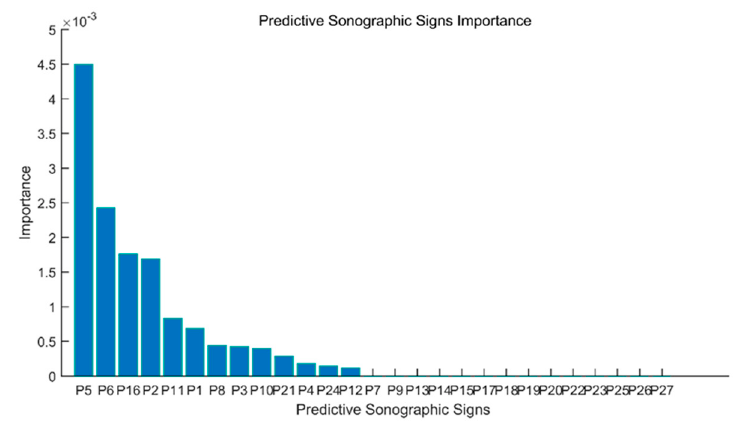
Figure 4. Rank values of 27 sonographic signs.